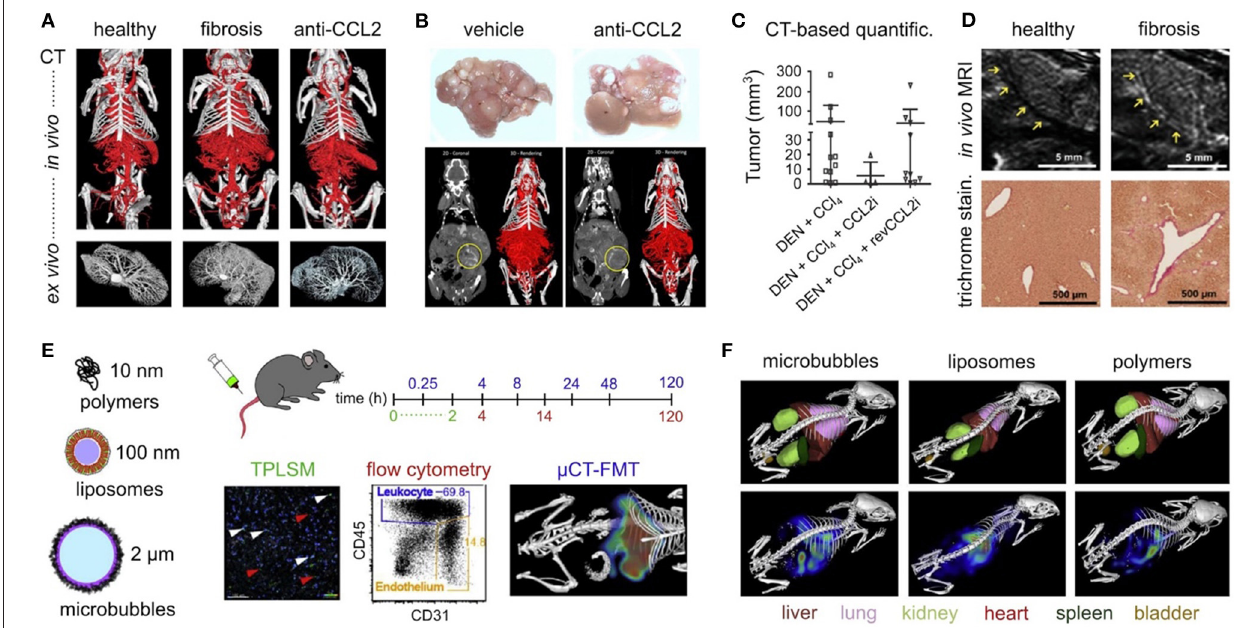
FIGURE 12 | Imaging liver fibrosis. (A) Contrast-enhanced in vivo and ex vivo micro-CT imaging reveals pathological angiogenesis in CCl 4 -induced liver fibrosis, as well as inhibition of fibrosis-associated angiogenesis upon anti-CCL2 RNA aptamer therapy. (B,C) Micro-CT-based assessment of the antitumor and anti-angiogenic effect of anti-CCL2 RNA aptamer therapy in the DEN-CCl 4 fibrosis-HCC mouse model. (D) ESMA-enhanced molecular MRI of perivascular elastin deposition in CCl 4 -induced liver fibrosis in mice. (E,F) Multimodal optical imaging was employed to demonstrate that CCl 4 -induced liver fibrosis affects the organ distribution and cellular accumulation of prototypic drug delivery systems in the liver. Images reproduced, with permission, from ( 118, 120, 196, 198,